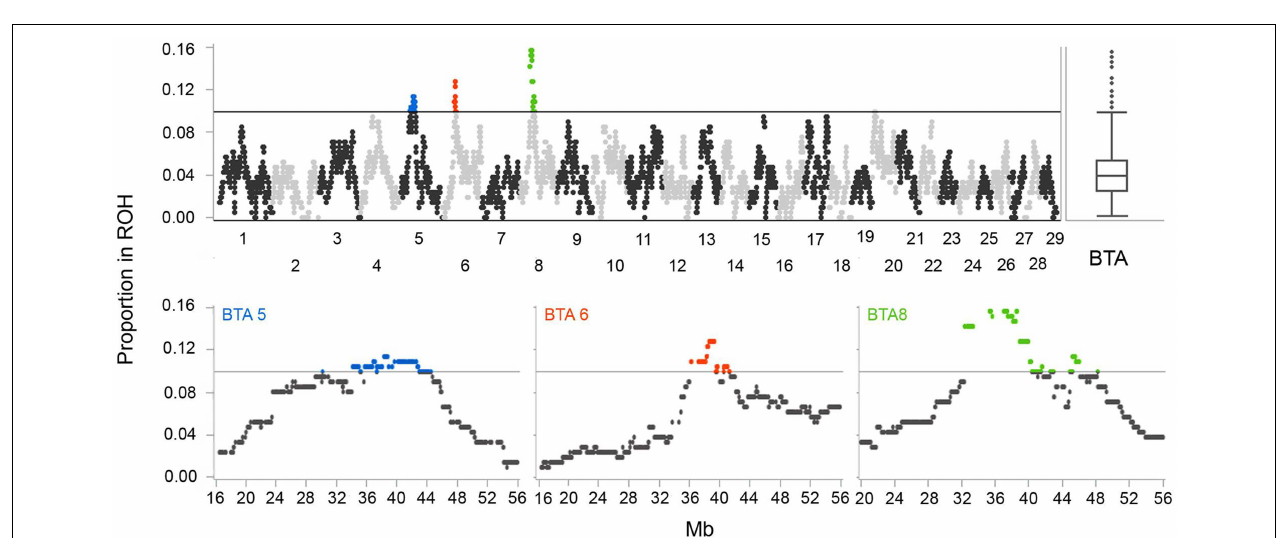
FIGURE 6 | Autozygosity islands, regions with extreme ROH frequency in Tyrol Grey cattle (minimum ROH length set to 4Mb).